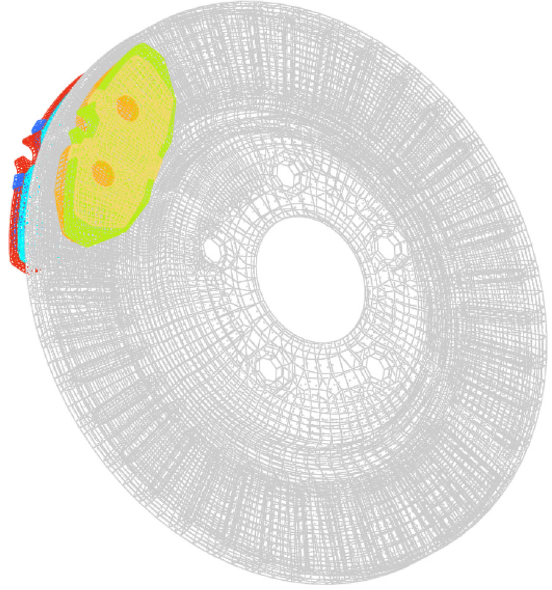
Fig. 4 FE model of the reduced brake